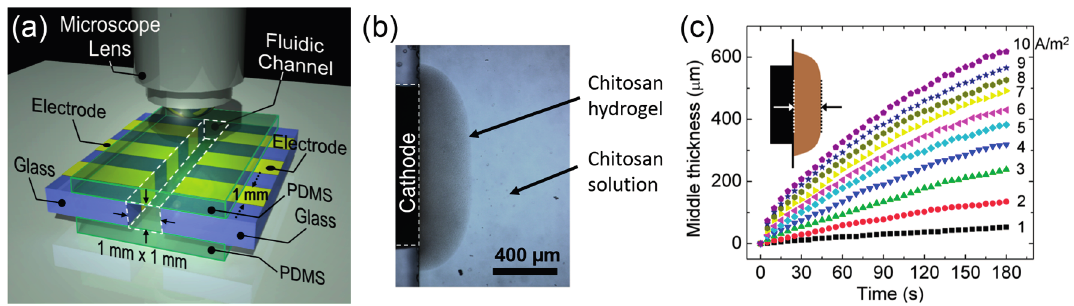
Figure 5. Cathodic electrodeposition allows control of chitosan film thickness. ( a ) Fabricated fluidic device used for in situ observation of chitosan’s electrodeposition. ( b ) Photograph of a chitosan film electrodeposited onto the sidewall electrode address. ( c ) In situ measurements of chitosan’s film thickness as a function of time and current density. Reproduced with permission from [77,78], published by Royal Society of Chemistry, 2010 and